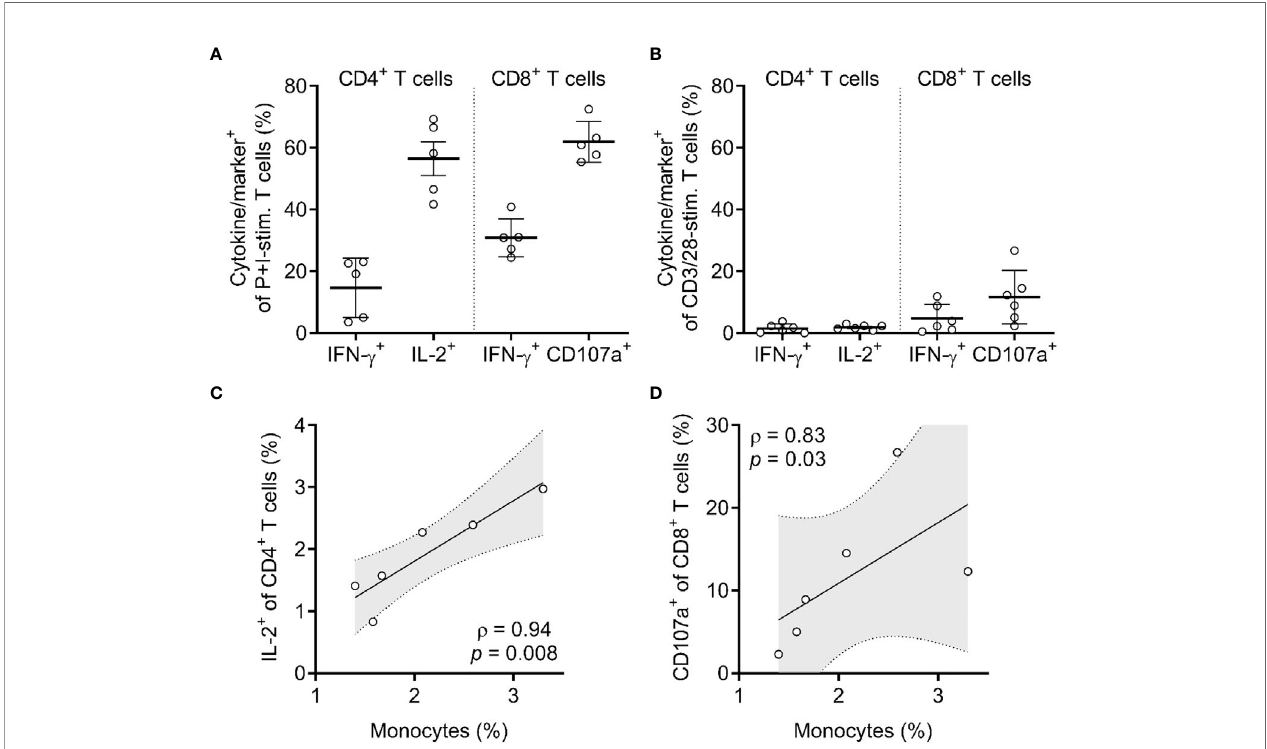
FIGURE 4 | T cells in HuBLT mice have impaired responsiveness that correlates with inadequate innate immune reconstitution. (A, B) CD4 + and CD8 + T cells from peripheral blood leukocytes of HuBLT mice ( n = 6 mice from 2 distinct human tissue donors) were assessed via fl ow cytometry for expression of the indicated cytokines or markers (i.e. IFN- g , IL-2, or CD107a) after stimulation with either PMA and ionomycin (P+I-stim., in A ) or anti-CD3/28 Dynabeads (CD3/28-stim., in B ). Although not shown, values for unstimulated cells were negligible (<0.5%). (C, D) Correlations were made between monocyte frequencies (percent of CD14 + cells of all hCD45 + cells) and the frequencies of responding (IL-2 + ) CD4 + T cells (in C ) and responding (CD107a + ) CD8 + T cells (in D ). For (C, D) , linear regression (black line) with 95% con fi dence intervals (gray shade) is depicted for visualization, as well as Spearman coef fi cients ( r ) with corresponding p